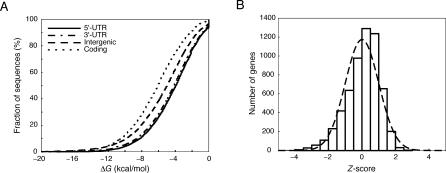
Folding Free Energies of 5′-UTRs(A) Cumulative distributions of folding free energies, ΔG, are shown for 5,888 ORFs for 5′-UTRs (50 nt upstream of the ORF; solid line), 3′-UTRs (50 nt downstream of the ORF; dashed-dotted line), coding sequences (50-nt sequences following downstream of the start codon of each ORF; dotted line), and 5,888 sequences of length 50 nt selected randomly from intergenic regions (dashed line).(B) Distribution of Z-scores for 5′-UTRs of 5,888 ORFs. Each 5′-UTR sequence was shuffled 100 times and a Z-score was calculated for each to compare the folding free energy of the native sequence to the shuffled sequences. A histogram of these Z-scores is shown together with a standard normal distribution (dashed line).